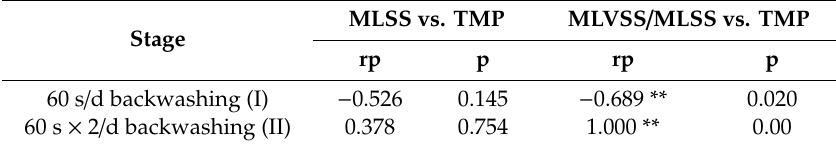
Table 5. Correlation analysis between the variations of MLSS with TMP.